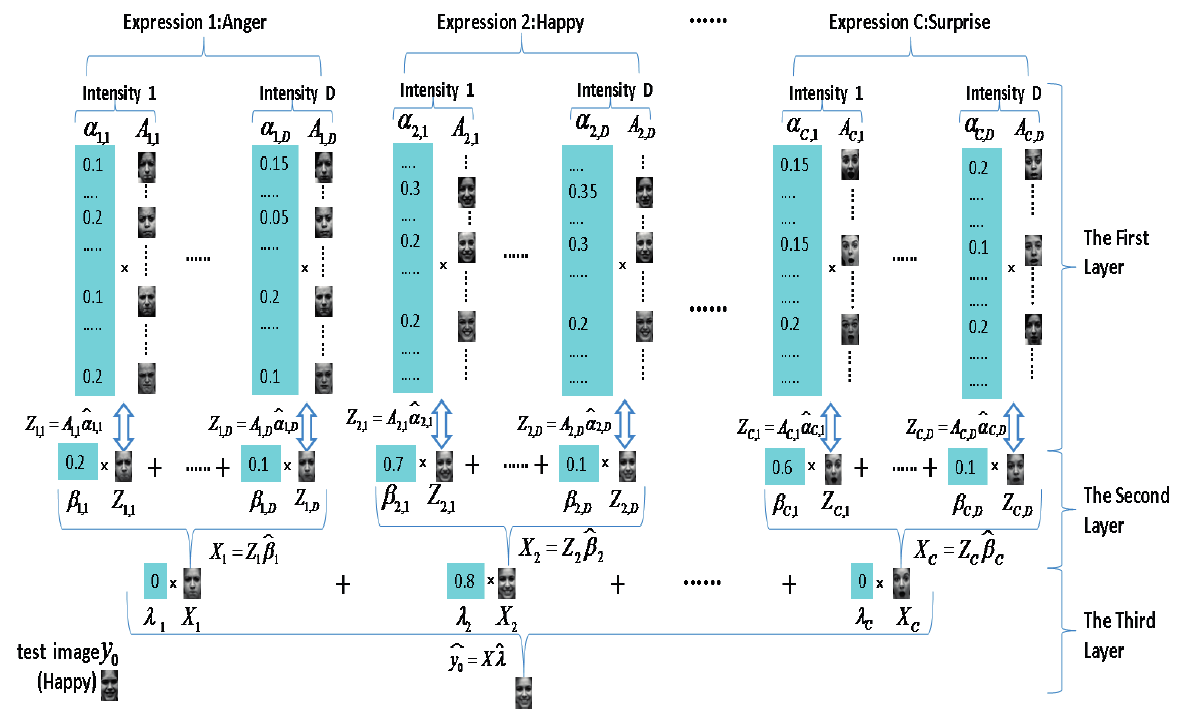
Figure 5. Multi-layer sparse representation